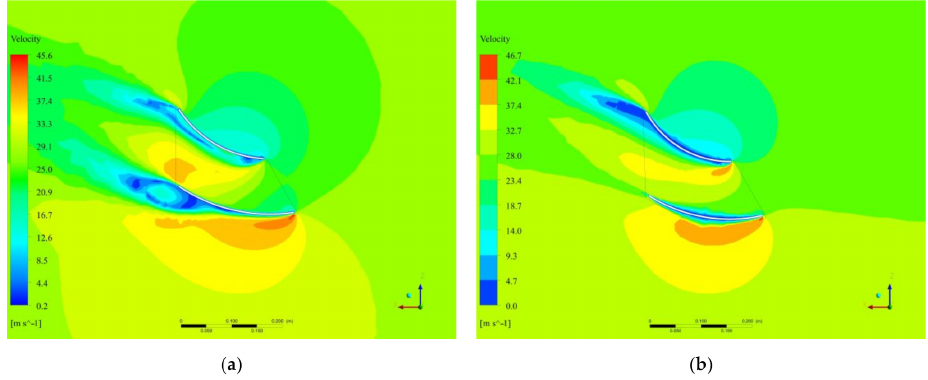
Figure 12. Flow state of otter board models 7 and 10 for an angle of attack of 30 ◦ : ( a ) Flow state of model 7; ( b ) Flow state of model